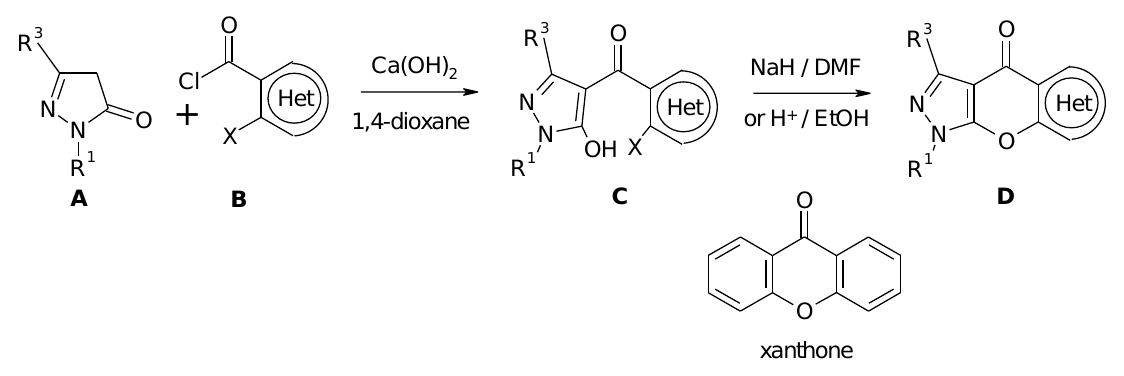
Figure 1. Synthesis of fused [2,3- c ]pyrazol-4(1 H )-ones D